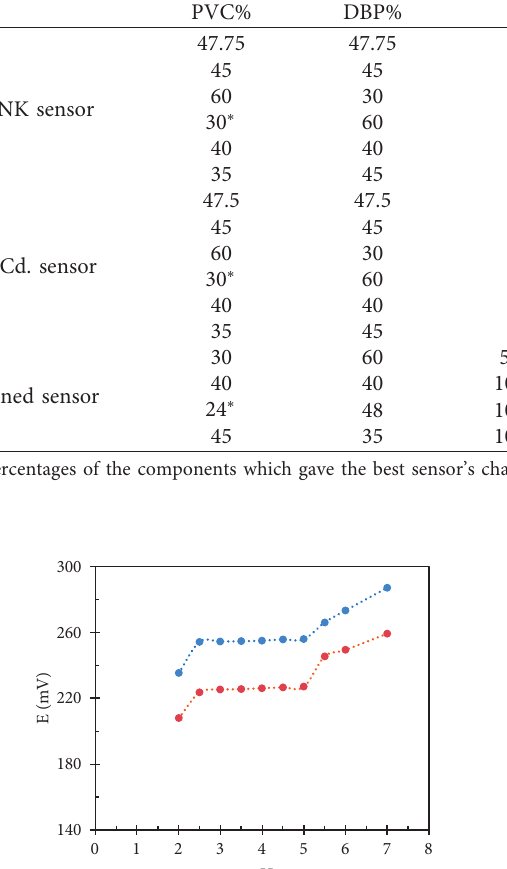
Table 2: Effect of the coating solution composition % ( w / w ) of DES- and MON-coated graphite sensors. Composition